Question: In a single sentence, describe what this figure presents.
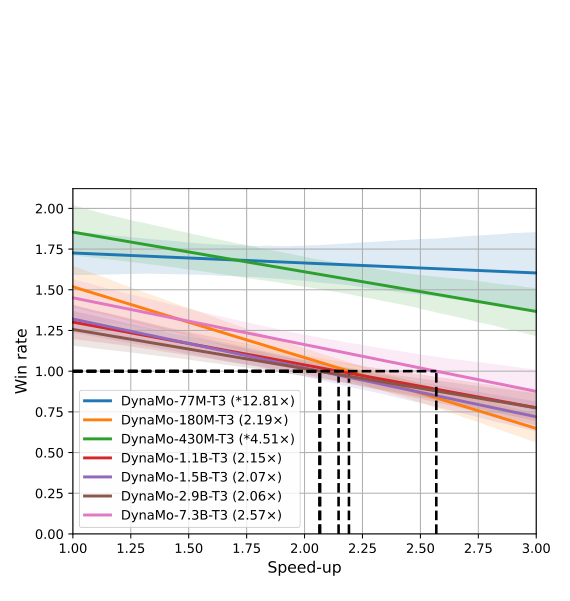
Answer: Win rate vs. speed-up for pairwise comparisons on the sentence-completion benchmark with corresponding Pythia models as baselines. GPT-3.5 is used as a judge. Re- gression plotted with 95% confidence intervals. Same-quality speed-ups are shown in parentheses. Theoretical same-quality speed-ups are marked with an asterisk (*).